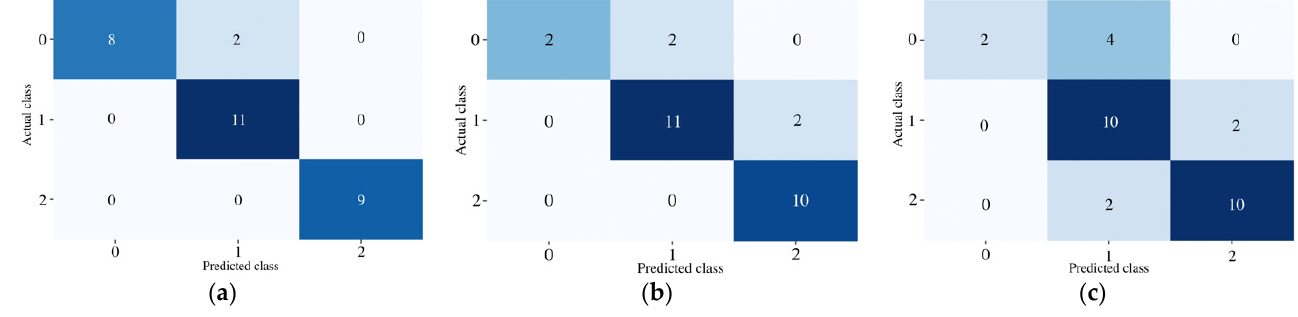
Figure 6. Confusion matrixes for separate systems: ( a ) cardiovascular; ( b ) muscular; ( c ) neural. The proposed work ability evaluation systems were constructed from separate RF health evaluation models. The final recommendations were generated according to classification results of cardiovascular, muscular, and neural systems. The schematic block of the proposed expert system is shown in Figure 7. The red circles represent the cardiovascular system, blue represents the muscular system, and yellow the neural system. All summed feature values were scaled and put into the hexagon web. Red dots indicate the asymmetry between left and right sides in muscle endurance side plank, static balance, or legs strength tests.